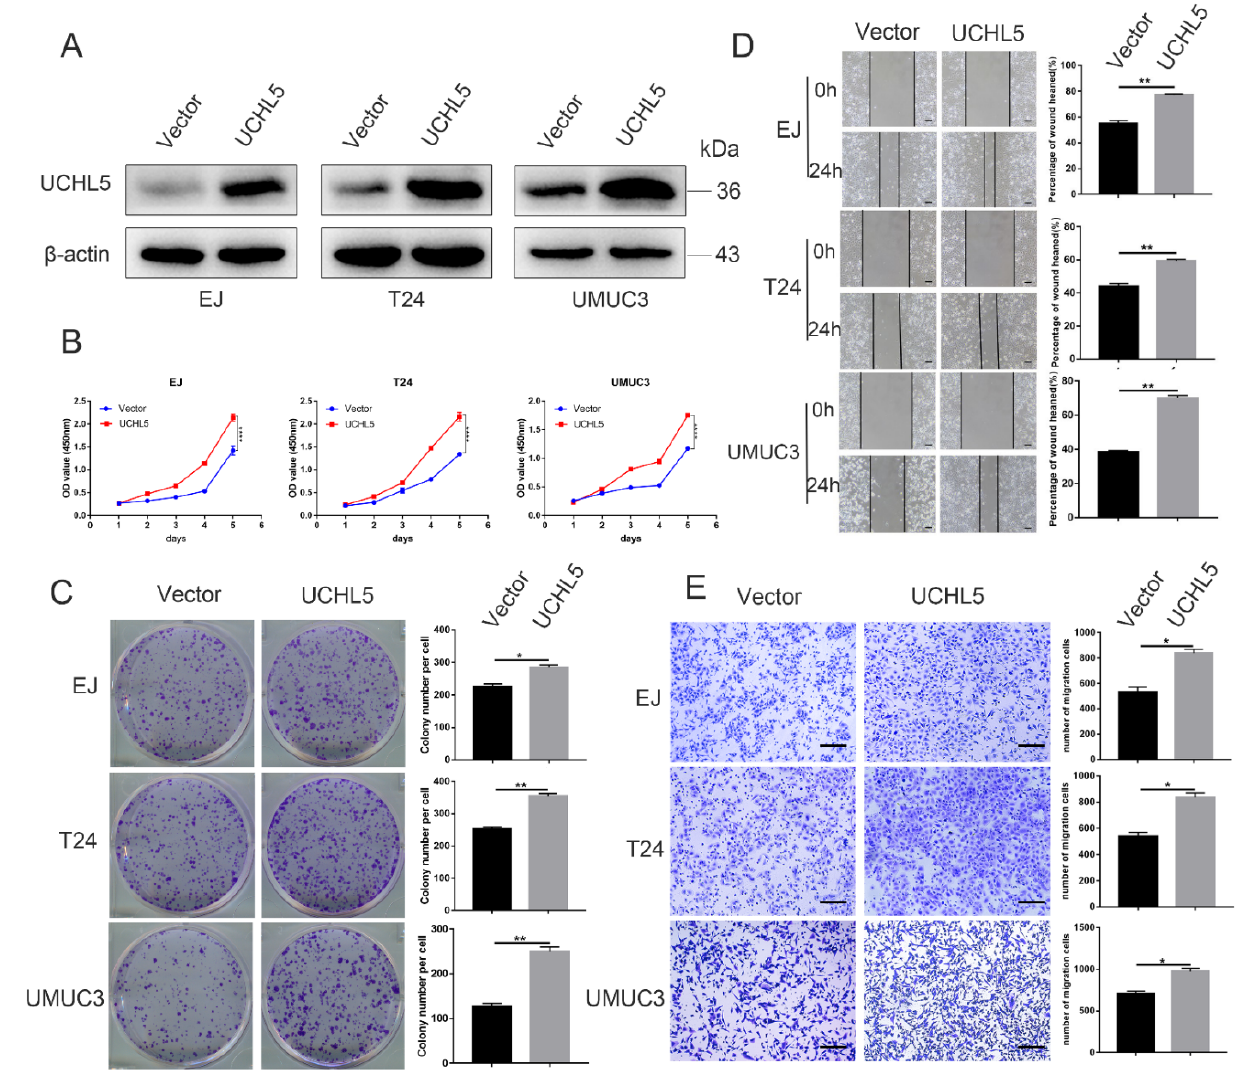
Figure 3. UCHL5 overexpression increases cancer cell proliferation and migration in vitro. ( A ) UCHL5 overexpression in bladder cancer cells confirmed by Western blotting. β -Actin is used as the loading control. ( B ) CCK-8 assays to examine the proliferation ability of bladder cancer cells between the UCHL5 overexpression group and vector group at five time points (24, 48, 72, 96, and 120 h). ( C ) Representative images of cell colony formation and the number of colonies were counted. ( D , E ) Cell migration was characterized using wound-healing (Scale bar = 100 μ m) and Transwell migration assay (Scale bar = 200 μ m). Values are shown as mean ± SD of three independent experiments. * p < 0.05, ** p < 0.01, and **** p < 0.0001 compared with controls.